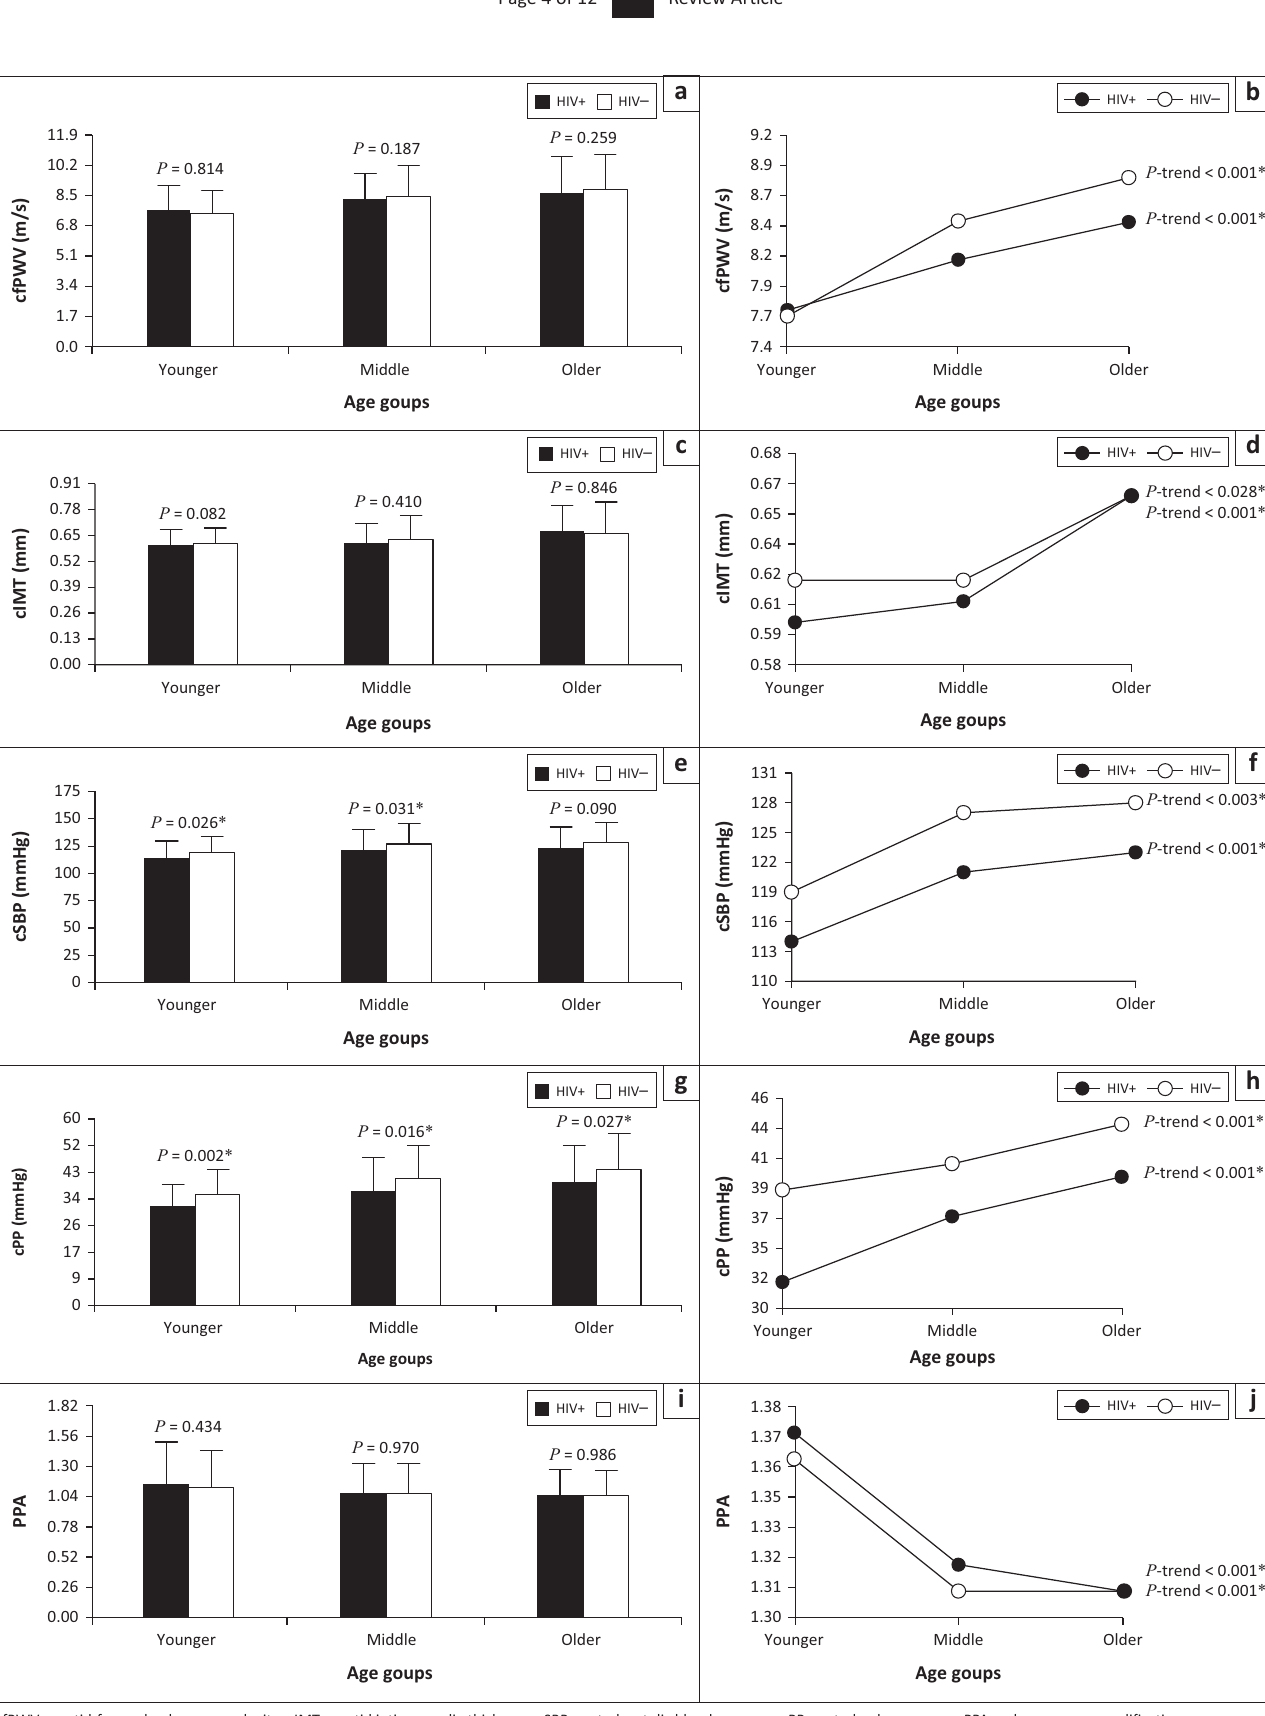
cfPWV, carotid-femoral pulse wave velocity; cIMT, carotid intima-media thickness; cSBP, central systolic blood pressure; cPP, central pulse pressure; PPA, pulse pressure amplification. FIGURE 2: Adjusted differences in vascular measures (cfPWV, cIMT, cSBP, cPP and PPA) between people living with HIV (HIV+) and without HIV (HIV–) according to tertiles of age (on the left), as well as across different age tertile groups within the respective HIV status groups (on the right). Confounders included for each dependent variable: cfPWV (sex and mean arterial pressure), cIMT (sex and mean arterial pressure), cSBP (sex), cPP (sex) and PPA (sex, mean arterial pressure, heart rate and